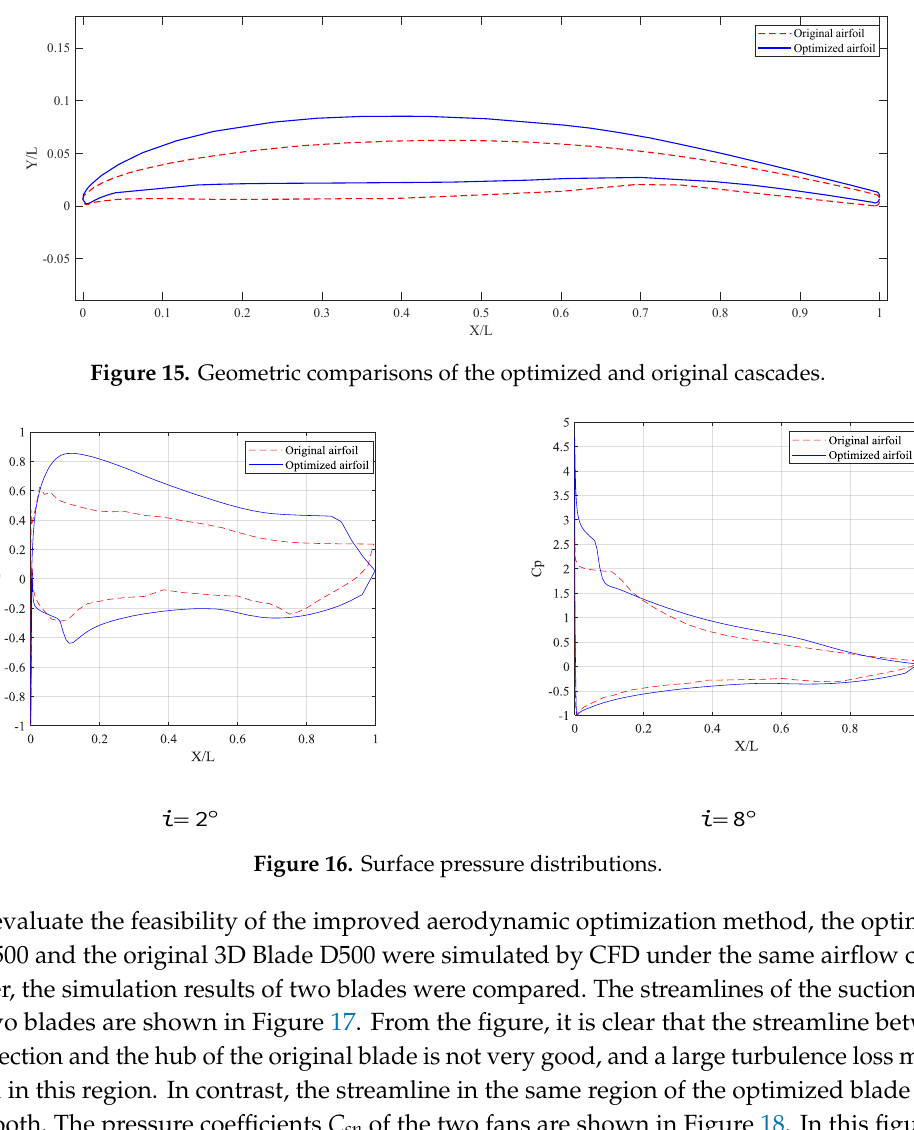
14 of 19 Figure 13. Static pressure coefficients calculated by CFD and the experiment. Figure 14. Average efficiencies calculated by CFD and the experiment. 4.2.2. Optimization of Blade D500 For aerodynamic optimization of the cascade at the 50% radius of Blade D500, the airflow condition was set as